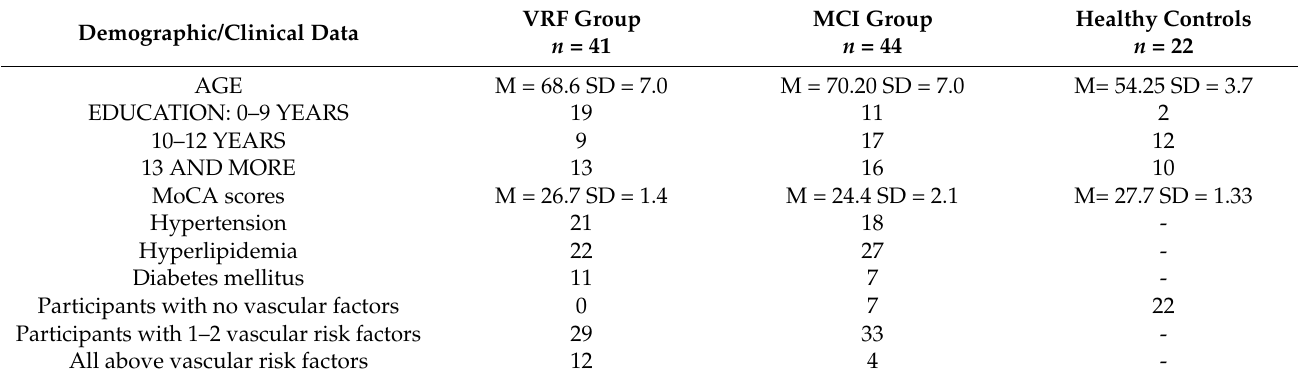
Table 1. Demographic data (means and standard deviations of age; frequence of educational levels) and clinical data (means and standard deviations of MoCA scores; and freqence of vascular risk factors) for the three